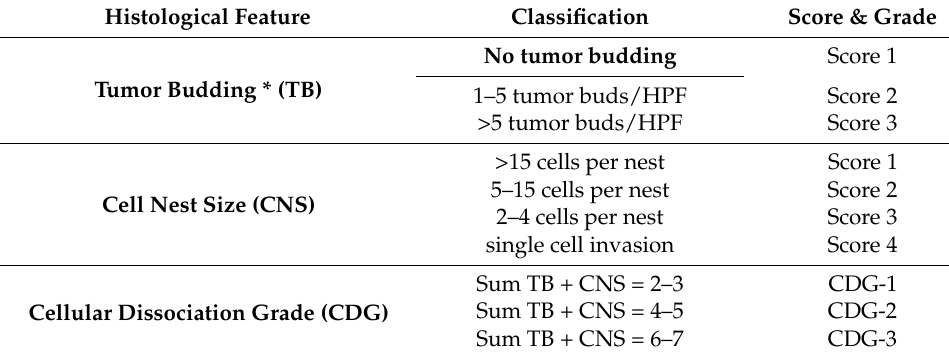
Table 1. Cellular dissociation grading [4–11].